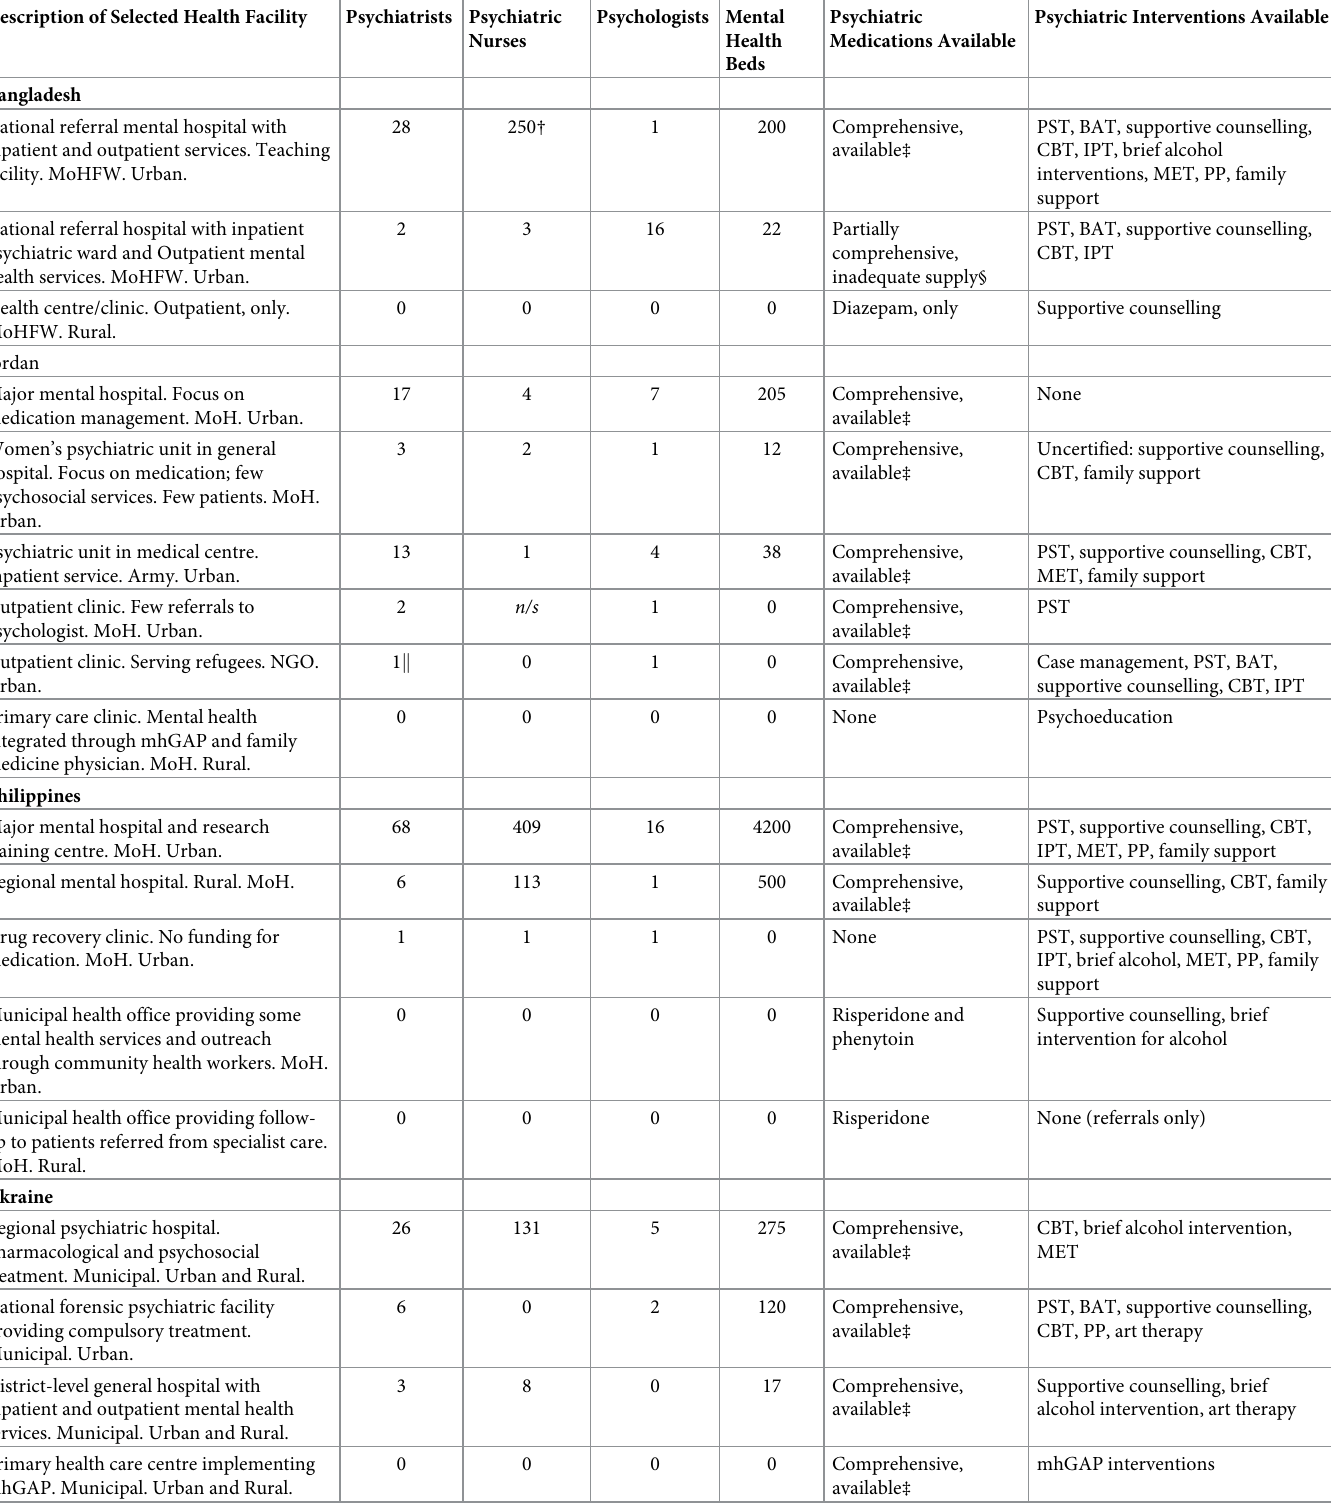
Table 5. Characteristics of selected health facilities �